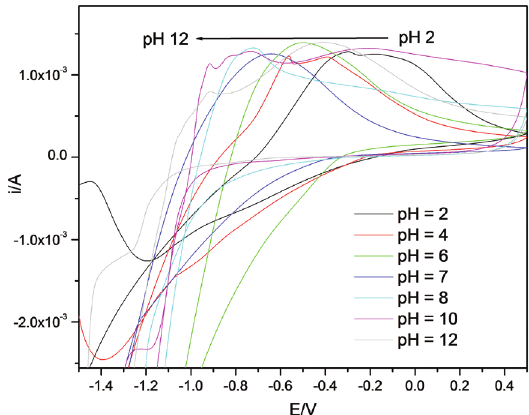
in buffer solution with pH values 3